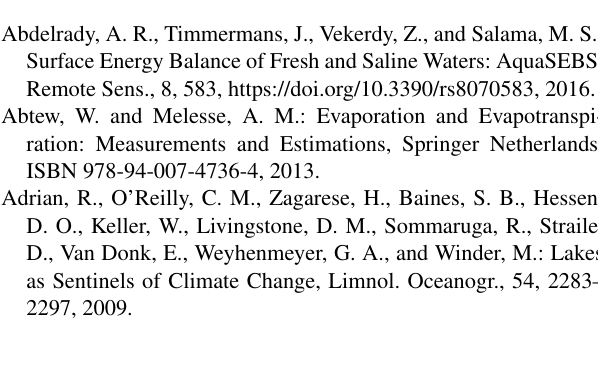
The abbreviations used in the table are as follows: Res. df – residual degrees of freedom, RSS – residual sum of squares, df – degrees of freedom, Sum of sq – sum of squares, F – value of F statistics, and Pr – p value for F statistics. Significance is represented as follows: [0, 0.001] “ ∗∗∗ ”; [0.001, 0.01] “ ∗∗ ”; [0.01, 0.05] “ ∗ ”; and > 0 . 05 “ ” (no